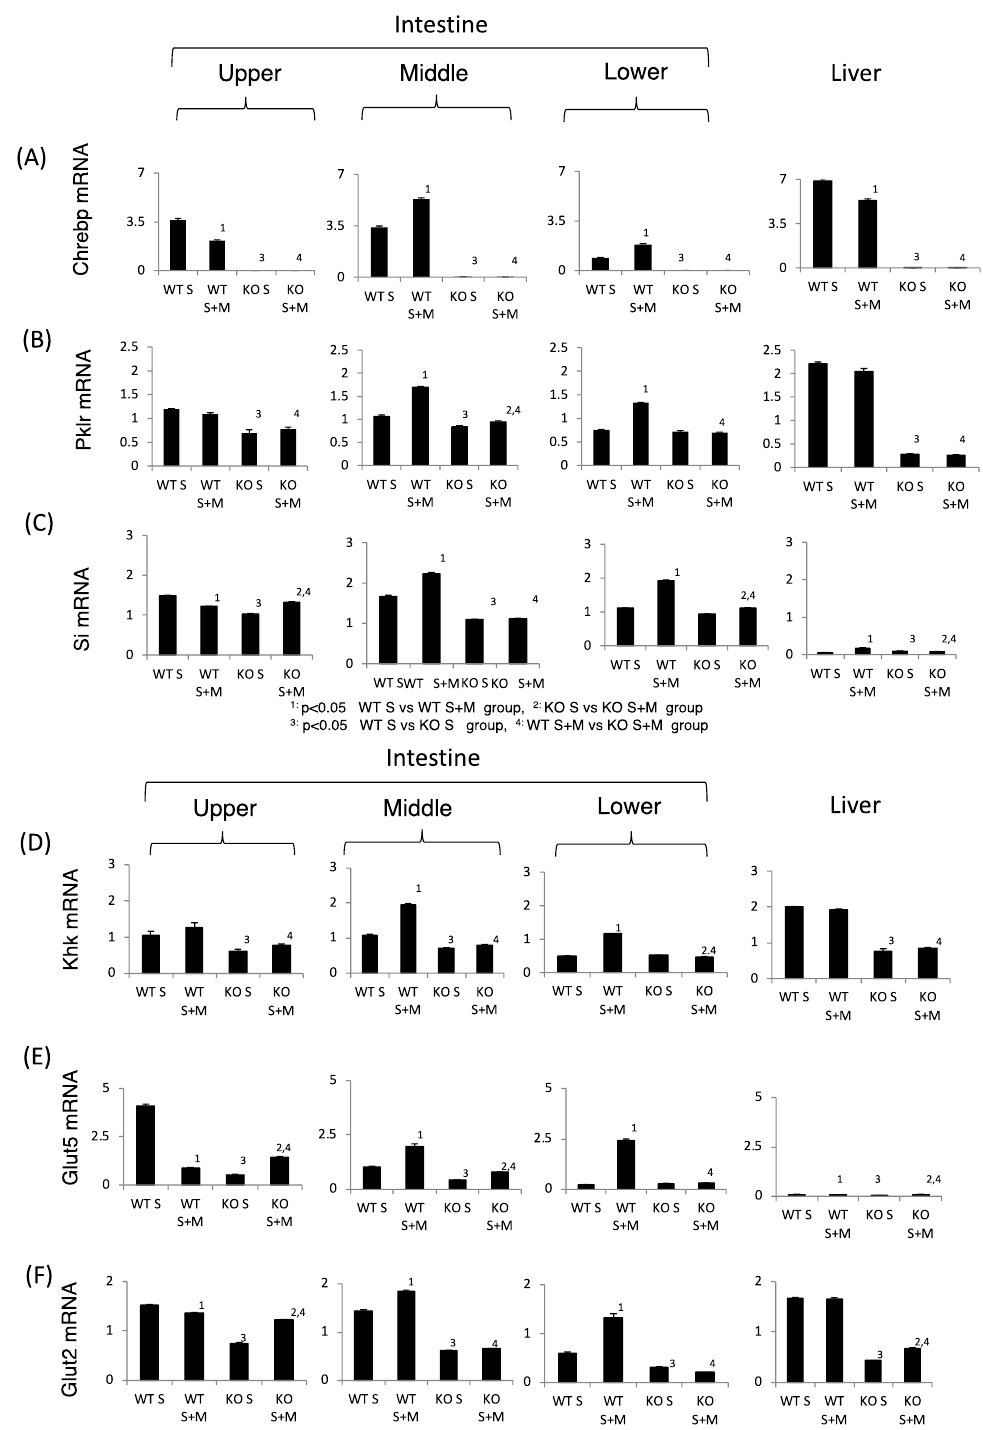
Figure 3. The effect of miglitol and the ChREBP gene deletion on genes related to ChREBP, fructose and sucrose metabolism. Eighteen week old male wild-type (WT) mice and ChREBP -knockout (KO) mice were fed a 30% sucrose (S) or 30% sucrose plus 0.08% miglitol (S + M)-containing diet for seven days. The intestine was divided into three parts (upper, middle and lower) and the mRNA levels were measured by real-time PCR. ( A ) ChREBP ; ( B ) liver pyruvate kinase ( Pklr ); ( C ) sucrase isomerase ( Si ); ( D ) ketohexokinase ( Khk ); ( E ) glucose toransporter 5 ( Glut5 ); and ( F ) glucose transporter 2 ( Glut2 ). Data represented as mean ± SD (n = 3 per group). 1 WT S vs. WT S + M, p < 0.05, 2 KO S vs. KO S + M, p < 0.05, 3 WT S vs. KO S, p < 0.05, and 4 WT S + M vs. KO S + M, p < 3.4. Fructose Is Difficult to Metabolize in the Intestine , but Not in the Liver